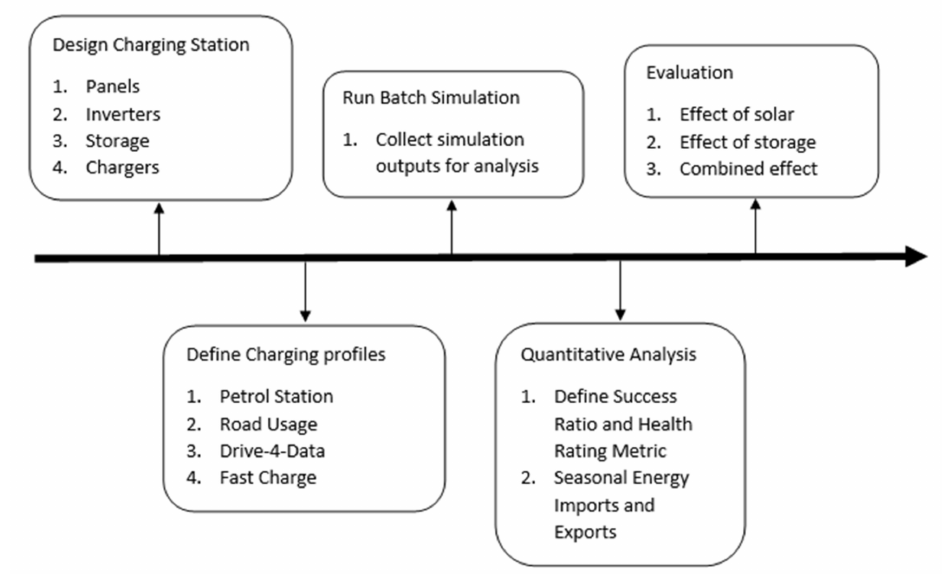
Figure 1. The project flowchart, detailing the phases of the